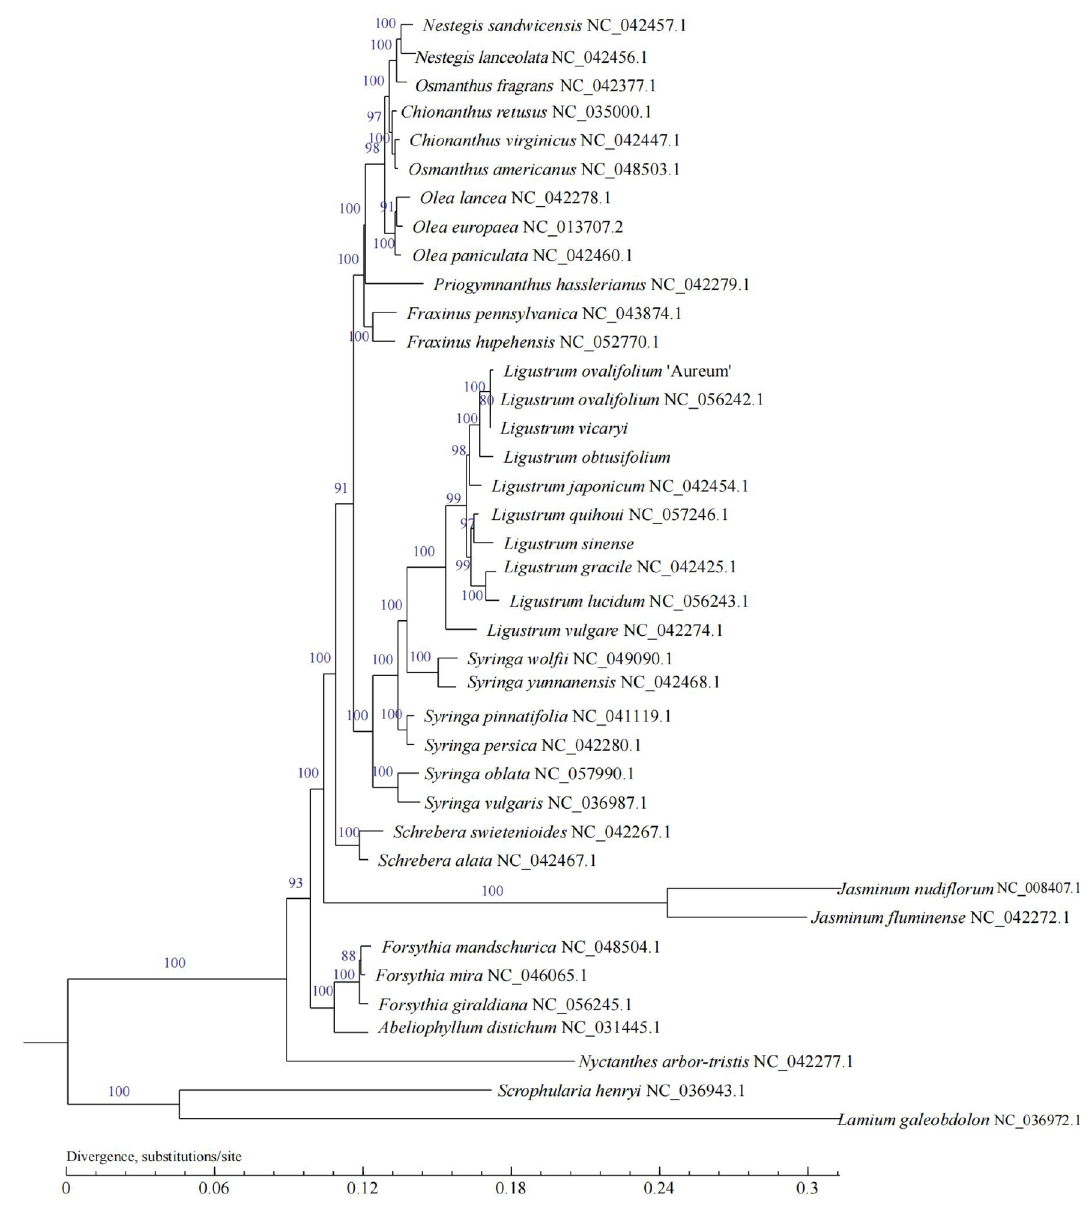
Figure 9. ML phylogeny of 39 species including 37 Oleaceae species and outgroups ( Scrophularia henryi and Lamium galeobdolon ) based on the whole chloroplast